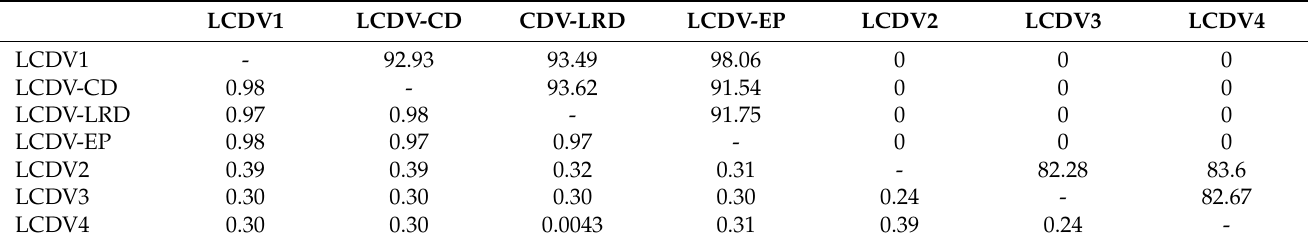
Table 3. LCDV pairwise genomic distance. The degree of genome relatedness ranges from warmer to cooler colors. Percentage identities are shown on the upper side of the table, and genetic distances are shown on the lower side. Genetic distances will range from 0 to 1: 1 represents identical genomic sequences; 0 means that genomic sequences are very